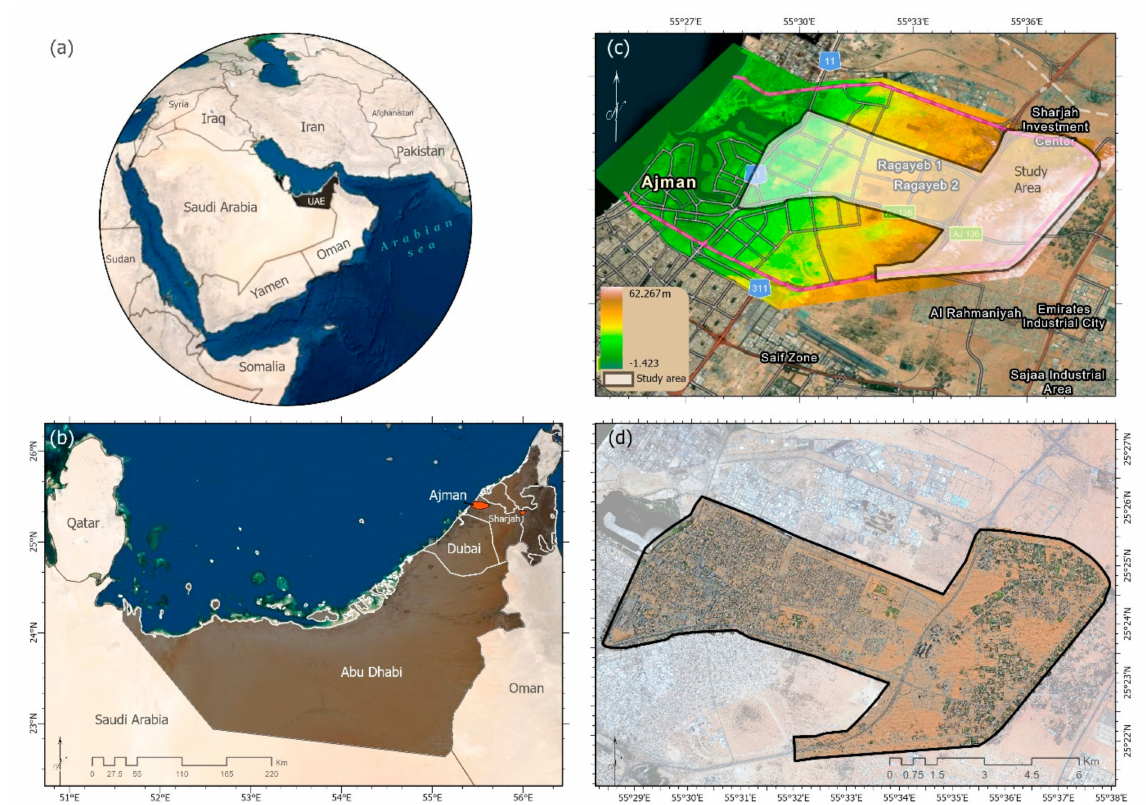
Figure 1. Geographical location of the study area: ( a ) the Middle East; ( b ) UAE; ( c ) location of the study area and the digital elevation model of Ajman Emirate; ( d ) UAV image of the study